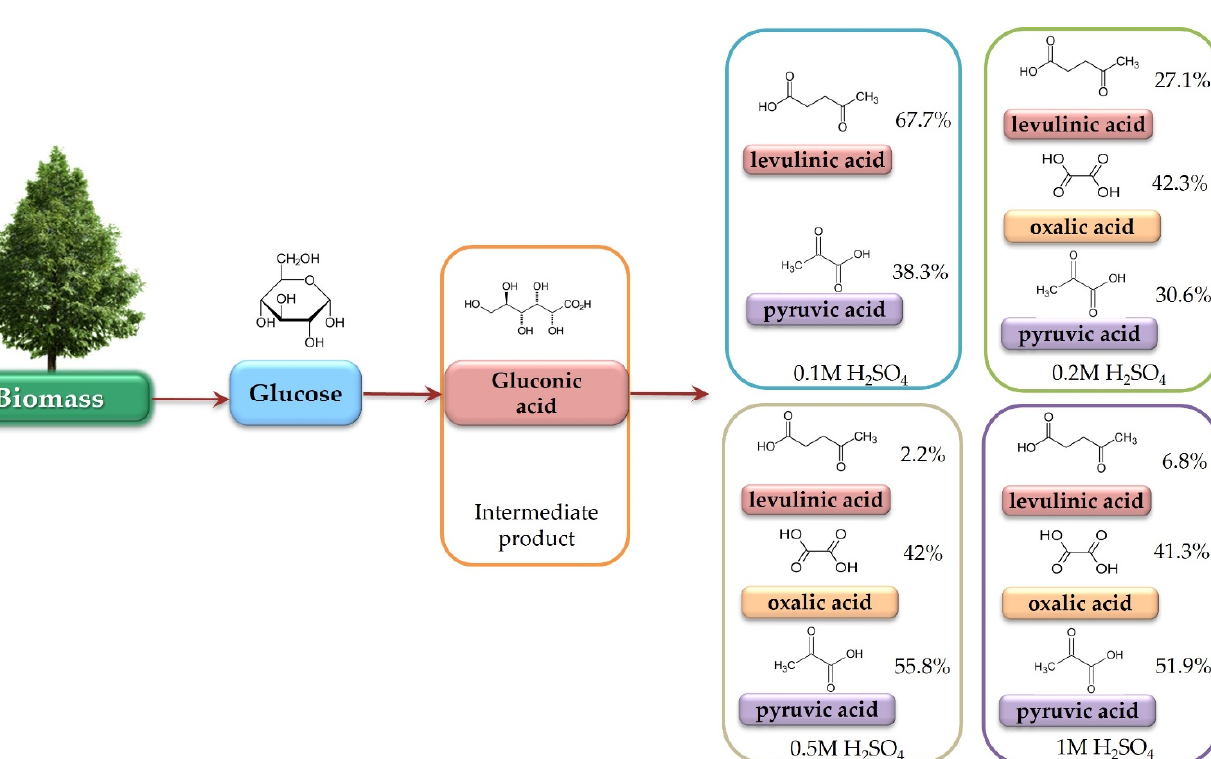
Figure 8. Summary of results based on HPLC analysis for homogeneous catalysis during glucose conversion. The results are related to the selectivity to the given product.